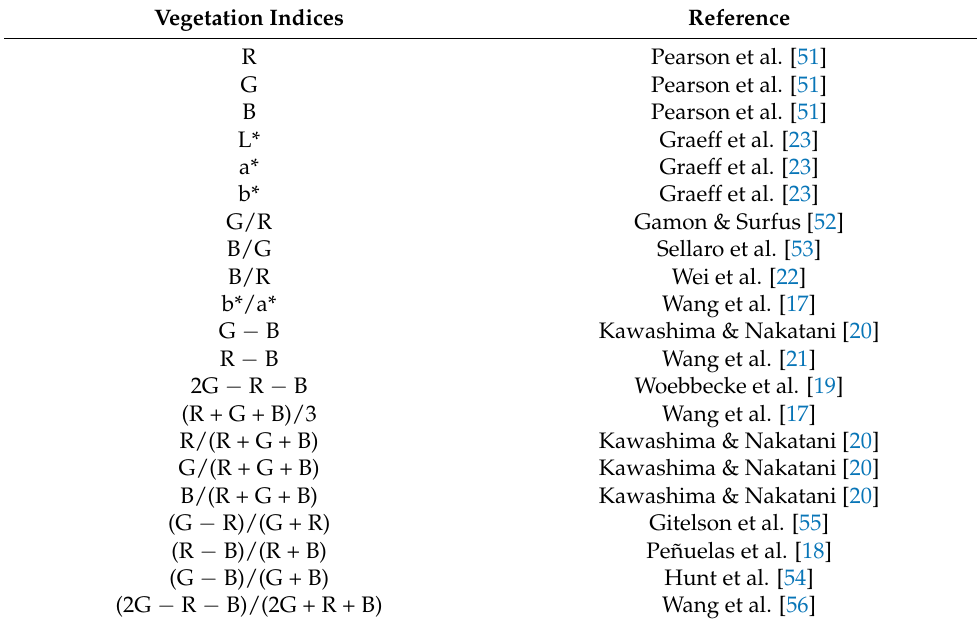
Table 2. Color-based vegetation